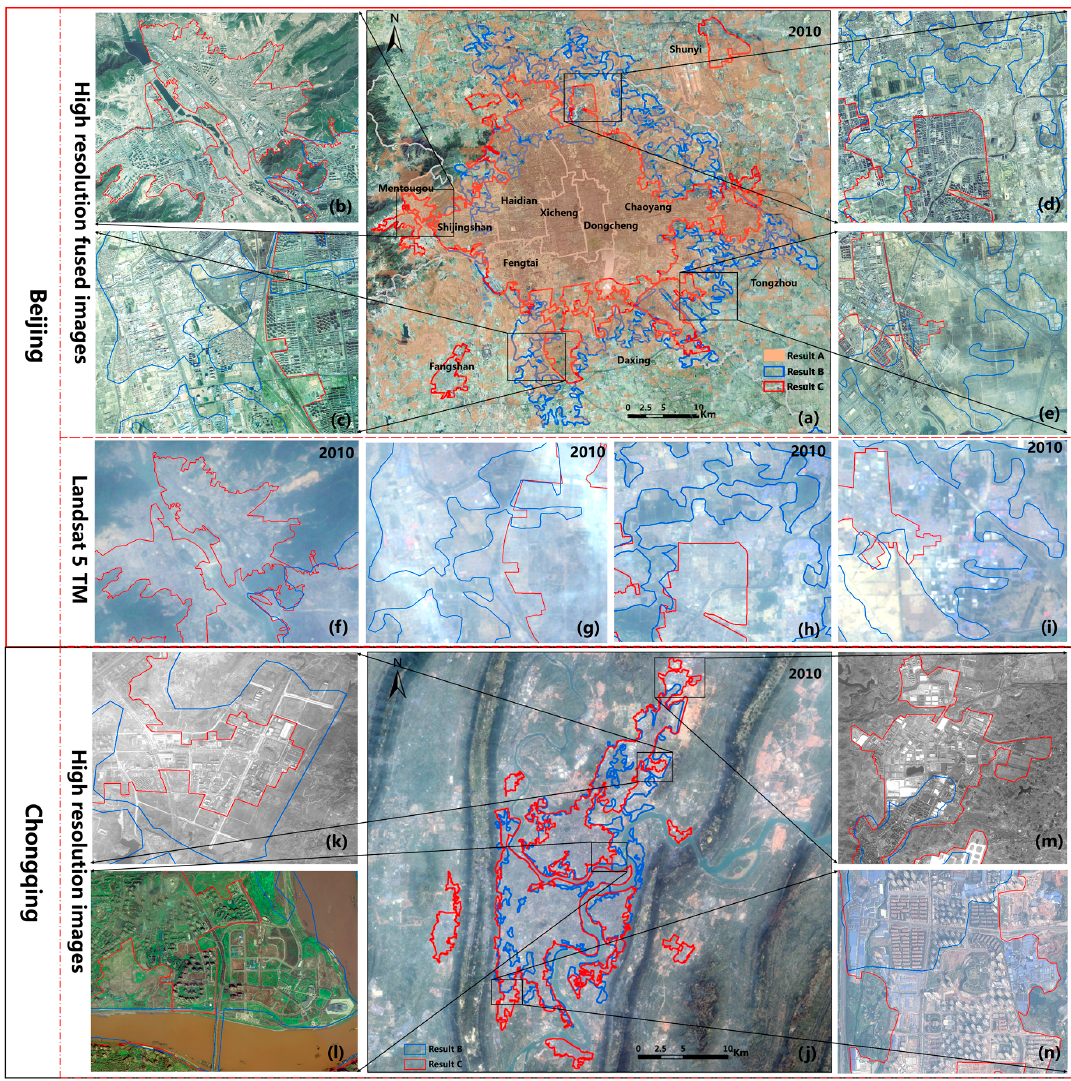
Figure 6. Comparison examples for urban boundaries of A, B and C in 2010—Beijing, Chongqing.